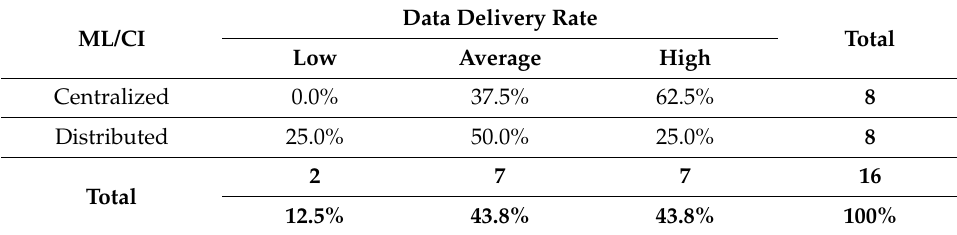
Table 5. Comparison of the data delivery rate according to the nature of the approach.